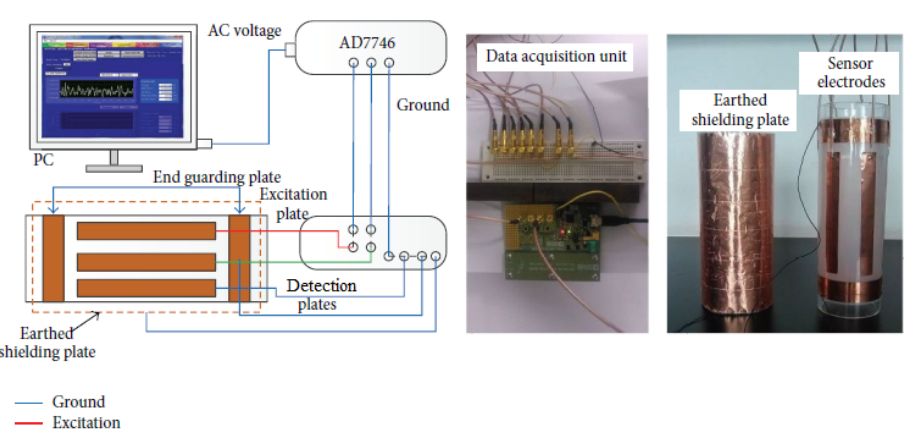
Figure 40. Schematic diagram and practical illustration of electrical capacitance measurement setup. Reprinted under Creative Commons CC BY license [32].